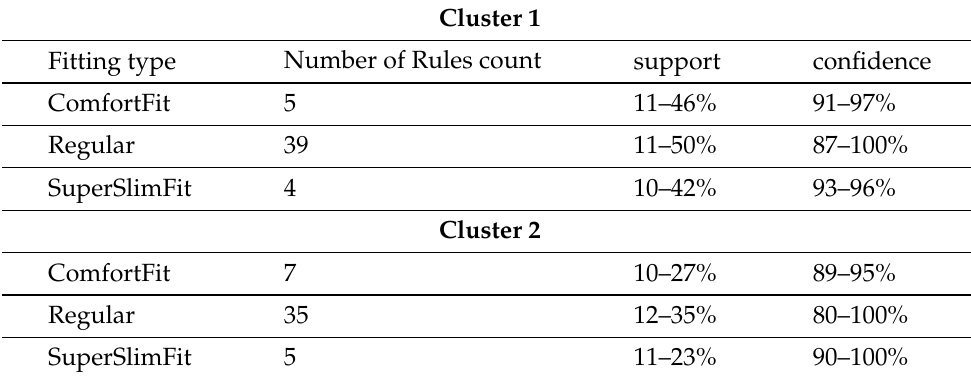
Table 4. Association rules statistic corresponding to each fitting